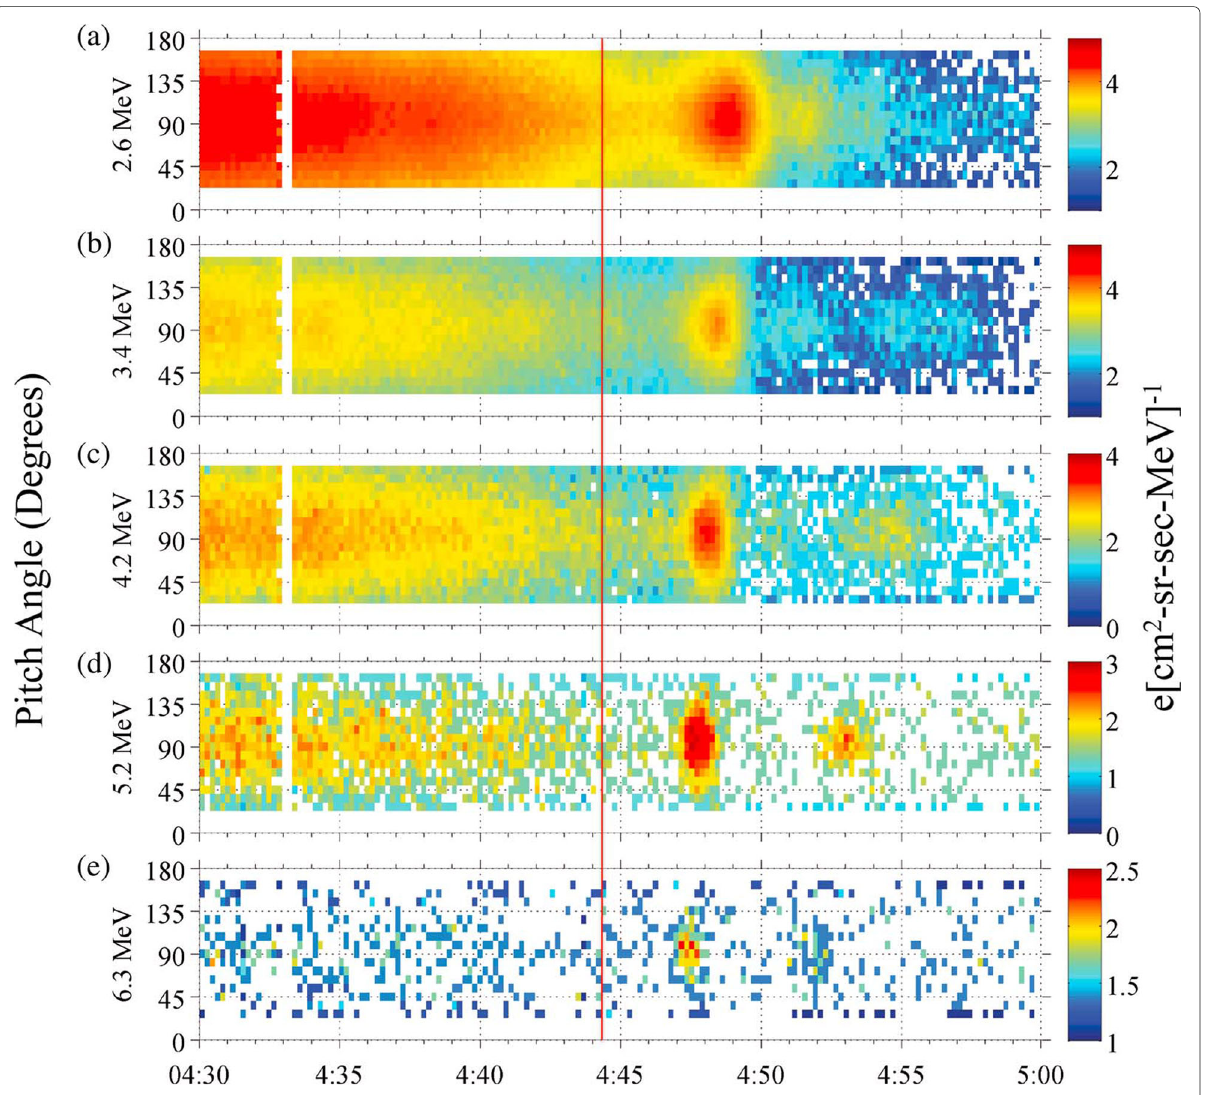
Fig. 12 REPT measurements (Van Allen Probe A) of pitch angle-resolved energetic electrons. Relativistic electron intensities at energies of 2.6, 3.4, 4.2, and 6.3 MeV are shown from the top to bottom panels, respectively. The red vertical line shows the IP shock arrival time (reproduced from Kanekal and et al.